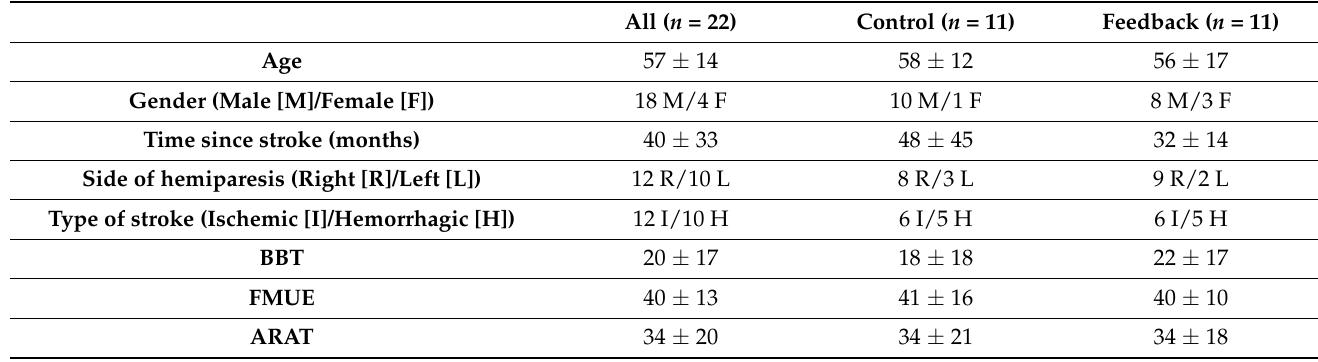
Figure 4. CONSORT flow diagram.